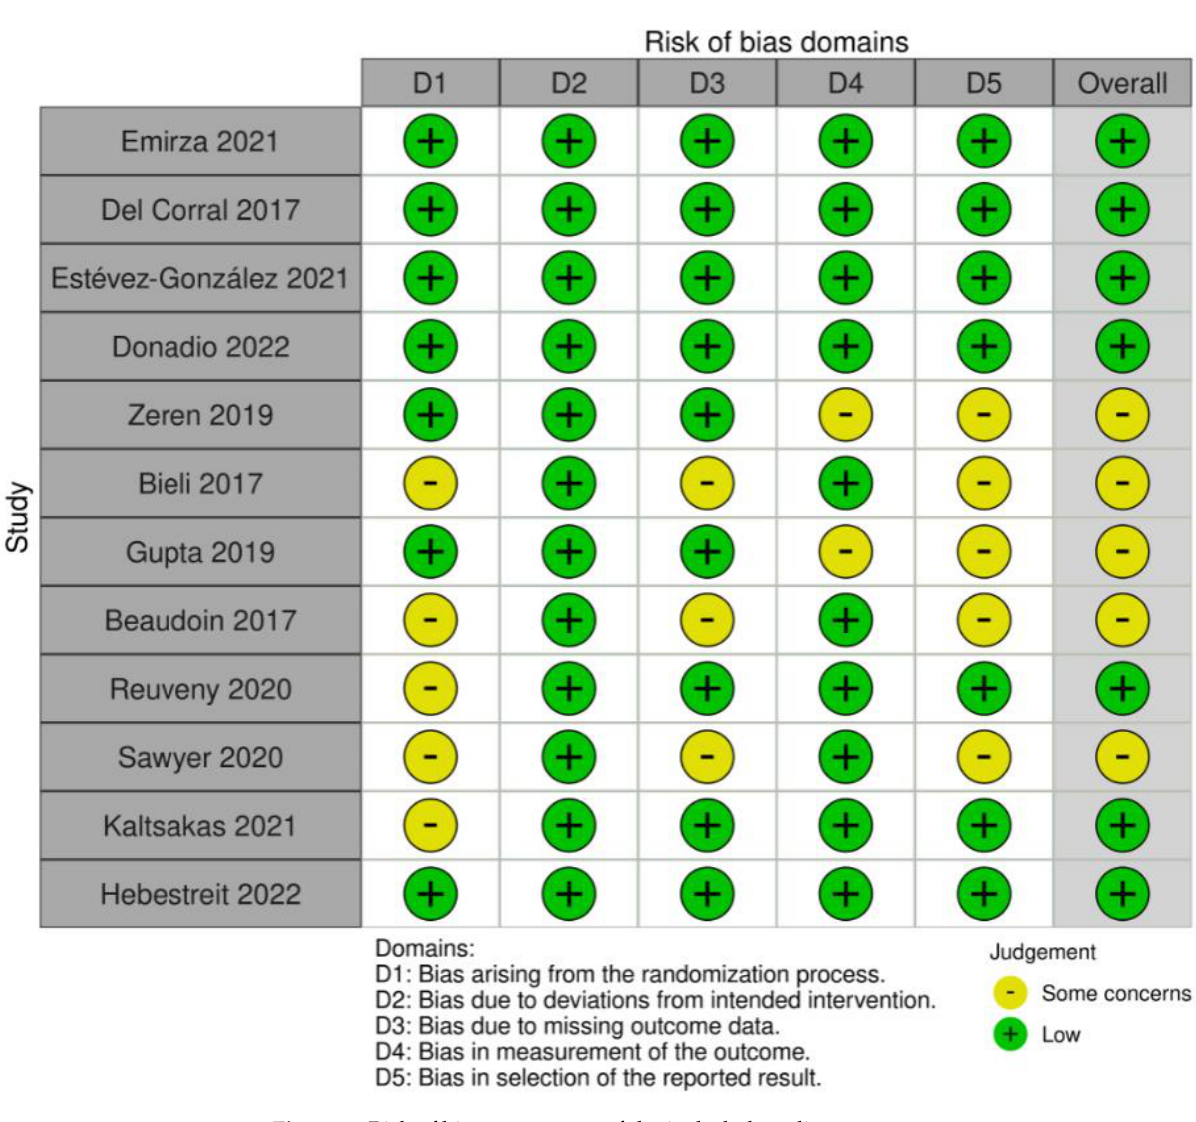
Figure 2. Risk of bias assessment of the included studies.